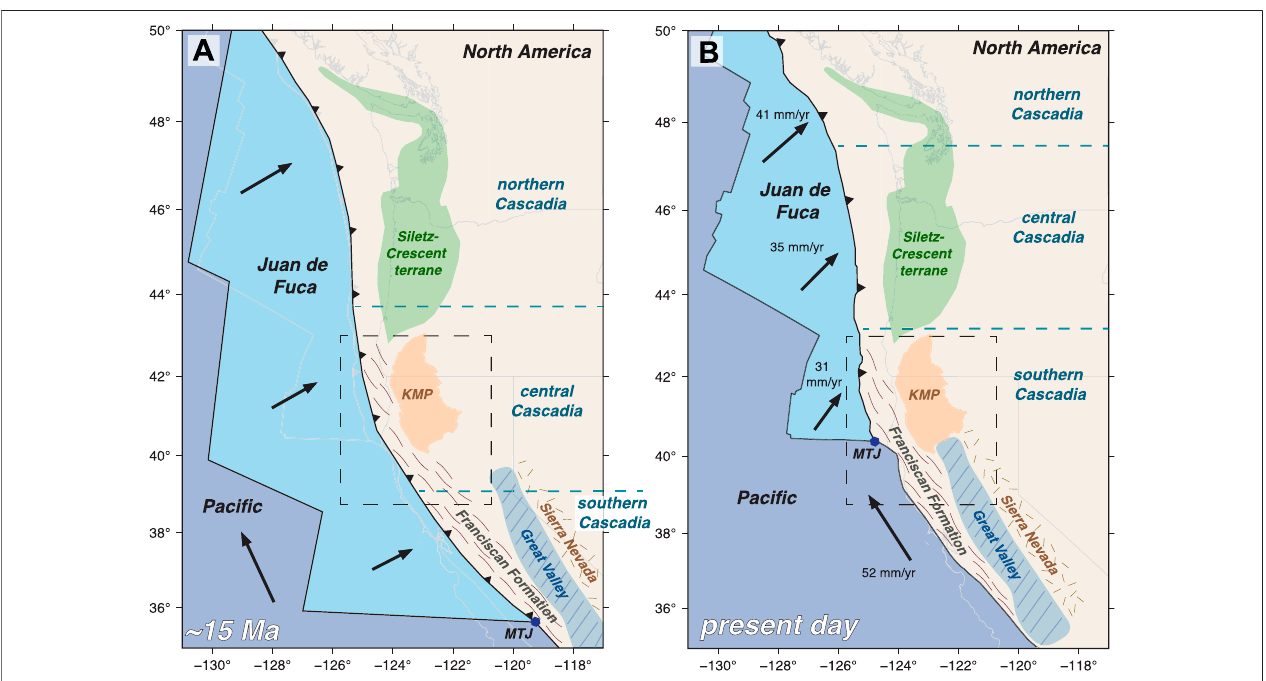
FIGURE 2 | Schematic plate reconstruction of the study region at ~15 Ma (A) and the present day (B) . The locations of key geological and tectonic terranes are highlighted. The study area is outlined by a dashed black box. At ~15 Ma (A) the study area (present-day southern Cascadia) is in central Cascadia. At present (B) the study area is within southern Cascadia. Reconstructions were done using the SNGV-North America Euler stage pole (d ’ Alessio et al., 2005), Paci fi c – Juan de Fuca Euler poles (Wilson, 1993) and Paci fi c-North America Euler poles (DeMets and Merkouriev, 2016).